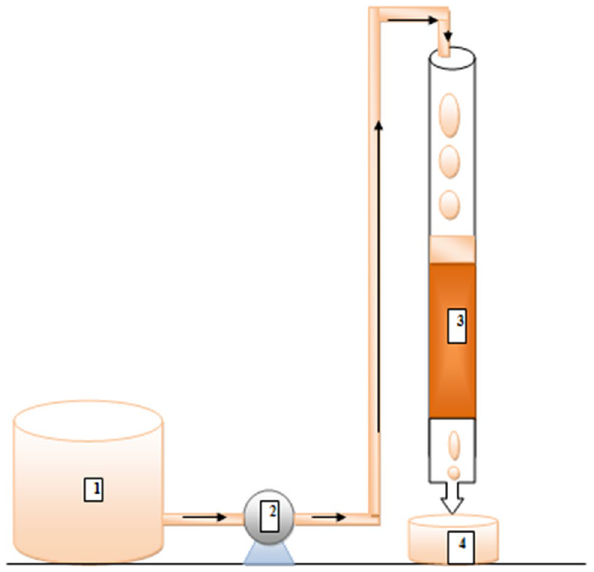
Fig. 1 Schematic diagram of column process. 1. Feed storage; 2. Pump; 3. Fixed-bed (adsorbent); 4. Effluent